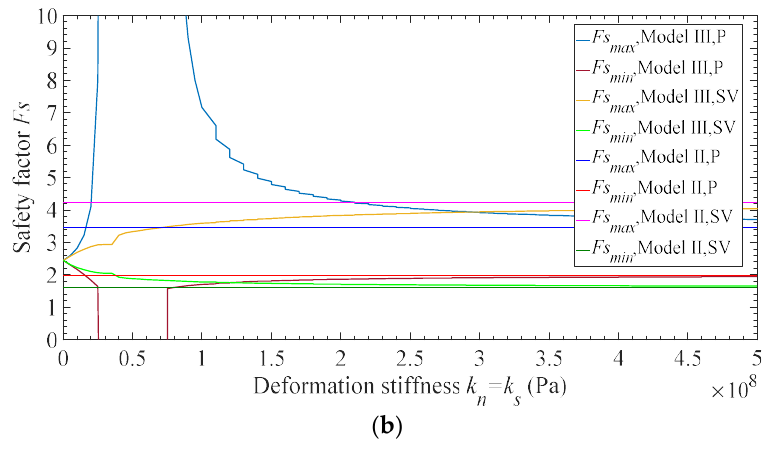
Figure 9. Instantaneous safety factor vs. deformation stiffness k = k n = k s : ( a ) comparison between models I and II; ( b ) comparison between models II and III.